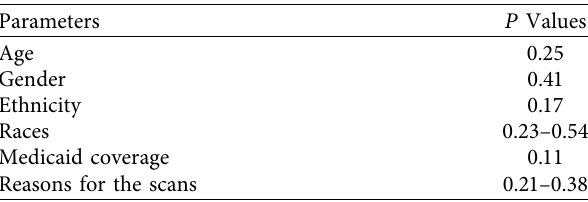
Reasons for the scans